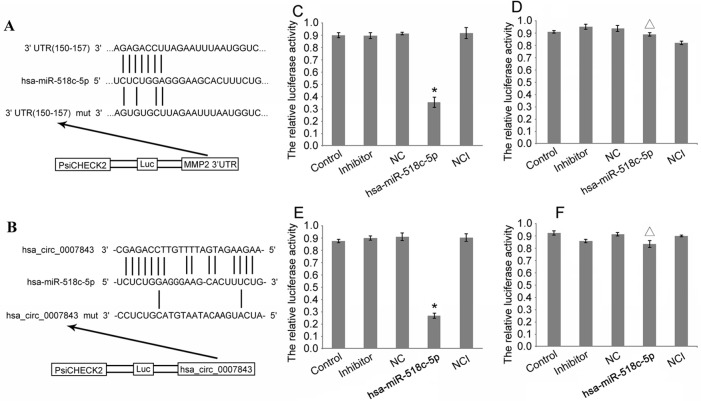
Construction of double fluorescent reporter gene vector to verify the interactions between hsa_circ_0007843, miR-518c-5p, and MMP2. (A) Target sequences for miR-518-5p in the 3′-UTR region of wild-type MMP2. (B) Target sequences for miR-518-5p on hsa_circ_0007843. (C) Comparison of luciferase activity in cells of different groups that were co-transfected with MMP2-3′UTR-WT; each bar represents the mean of 3 independent experiments. *
P < 0.05. (D) Luciferase activity in cells of different groups that were co-transfected with MMP2-3′UTR-Mut; each bar represents the mean of 3 independent experiments. Δ
P > 0.05. (E) Comparison of luciferase activity in cells of different groups that were co-transfected with hsa_circ_0007843-WT; each bar represents the mean of 3 independent experiments. *
P < 0.05. (F) Luciferase activity in cells of different groups that were co-transfected with hsa_circ_0007843-Mut; each bar represents the mean of 3 independent experiments. Δ
P > 0.05. Control group (psiCHECK-2-cirRNA/psiCHECK-2-mRNA, psiCHECK-2-cirRNA-mut/psiCHECK-2-mRNA-mut), inhibitor (inhibitor for miRNA + psiCHECK-2-cirRNA/psiCHECK-2-mRNA, psiCHECK-2-cirRNA-mut/psiCHECK-2-mRNA-mut), NC group (negative control sequence + psiCHECK-2-cirRNA/psiCHECK-2-mRNA or psiCHECK-2-cirRNA-mut/psiCHECK-2-mRNA-mut), NCI group (inhibitor for negative control + psiCHECK-2-cirRNA/psiCHECK-2-mRNA or psiCHECK-2-cirRNA-mut/psiCHECK-2-mRNA-mut sequence), hsa_miR-518c-5p group (hsa_miR-518c-5p mimics + psiCHECK-2-cirRNA/psiCHECK-2-mRNA or psiCHECK-2-cirRNA-mut/psiCHECK-2-mRNA-mut).